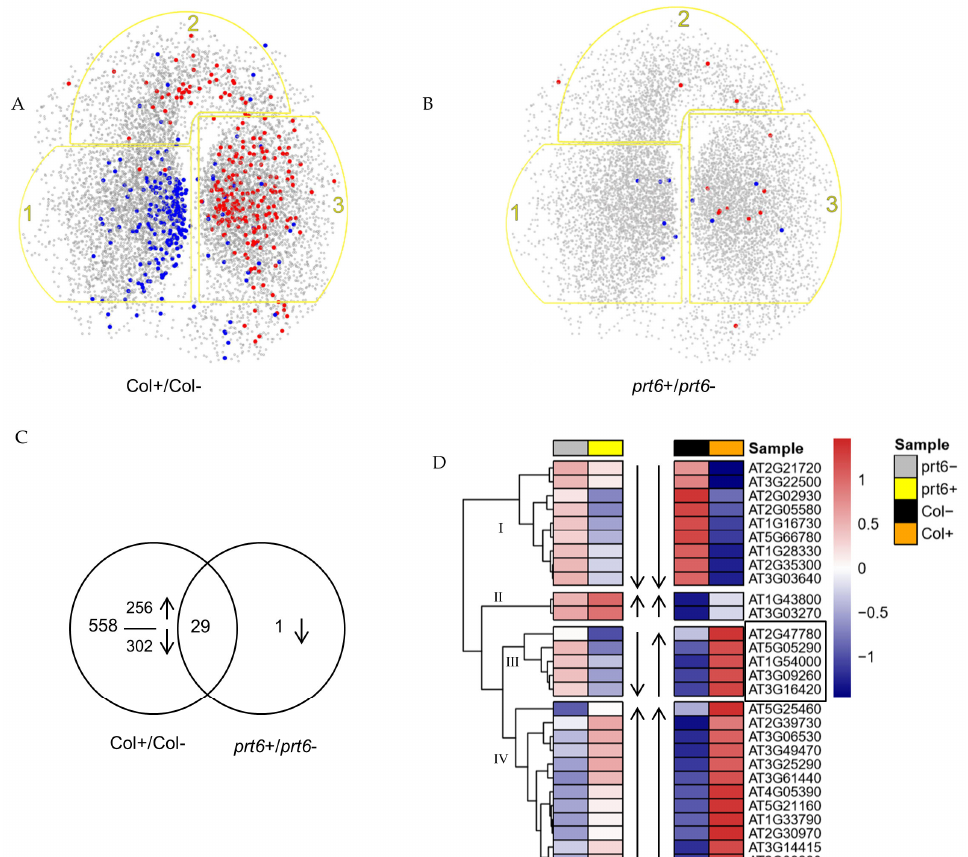
Figure 4. Classi fi cation of DEGs from comparison groups, Col+/Col − and prt6 +/ prt6 − . ( A , B ): Localization of the DEPs from group Col+/Col − ( A ) and prt6+/prt6 − ( B ) in the SeedNet gene co ‐ expression network. Yellow outlines indicate as follow: region 1, genes associated with seed dormancy; region 3, genes associated with seed germination; and region 2, genes associated with dormancy ‐ germination transition. Red dots and blue dots represent down and up ‐ regulated proteins in corresponding group. ( C ): A Venn diagram showing the common and specific proteins in groups, Col+/Col − and prt6 +/ prt6 − , up and down ‐ arrows indicate up and down ‐ regulated proteins, respectively. ( D ): A hierarchical clustering of the 29 common DEPs in Col+, Col − , prt6 +, prt6 − . The top bars show the clustering of the different samples, prt6 − (grey), prt6+ (yellow), Col − (black) and Col+ (orange). In the heatmap, blue represents down ‐ regulated expression, red represents up ‐ regulated expression and white represents no change in expression. The inner arrows represent the effect of ethylene on prt6 and Col with showing up ‐ arrow if fold change ratio (Col+/Col − or prt6+/prt6 − ) < 1, down ‐ arrow if fold change ratio (Col+/Col − or prt6+/prt6 − ) > 1. Gene trees were divided into 4 clusters indicated by I, II, III, IV. Seeds harvested in 2016.